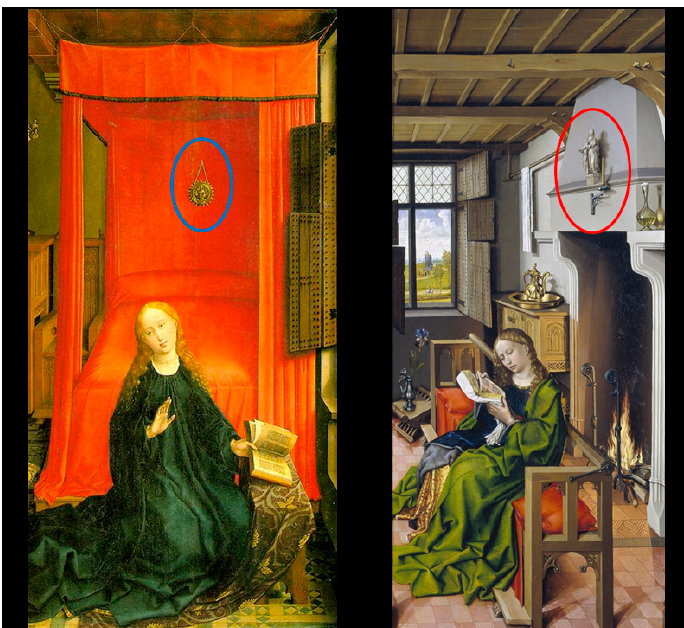
Figure 4. ( left ) Rogier van der Weyden, Annunciation Triptych (detail of center panel), 1440. Paris: Louvre. Note hanging devotional piece on the back bed-curtain. Photo: Wikimedia. ( right ) Robert Campin/Master of Flémalle, St. Barbara , wing of Werl Altarpiece, 1438. Madrid: Prado. Note image of the Trinity on the mantle. Photo: Wikimedia.